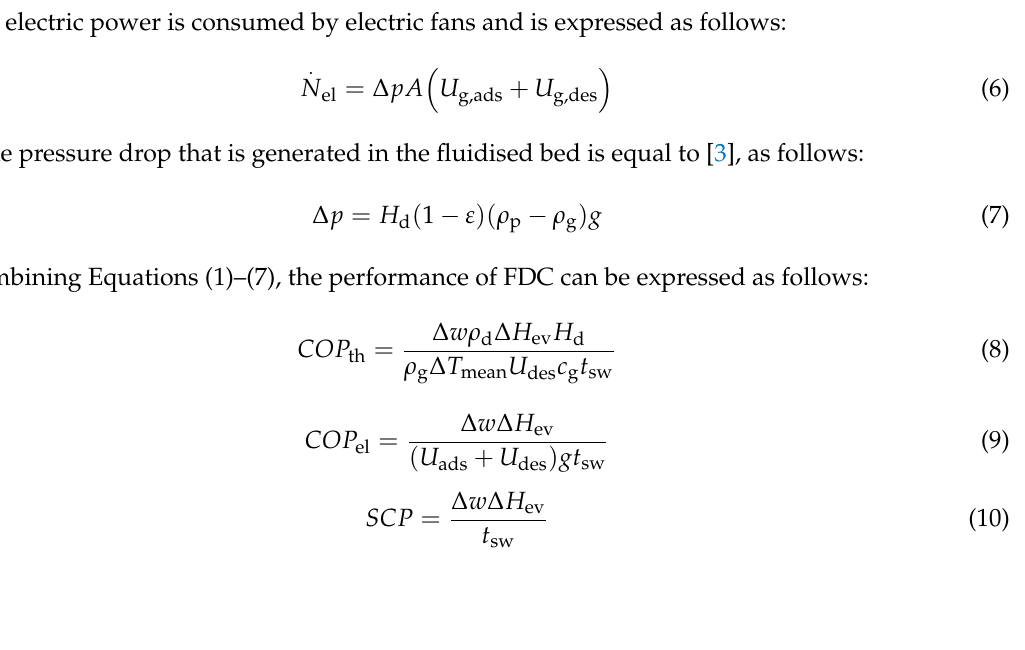
Figure 1. The scheme of the fluidized desiccant cooler (FDC). 1—humidifier, 2—air cooler, 3—fluidized beds, 4—electric fan, 5—air cooler, 6—air heater, 7—recovery heat exchanger, and 8—electric fan.